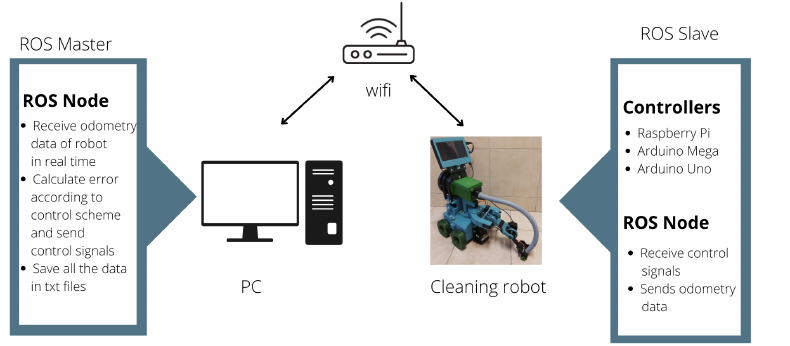
Figure 4. Working diagram of real-time data exchange between PC and